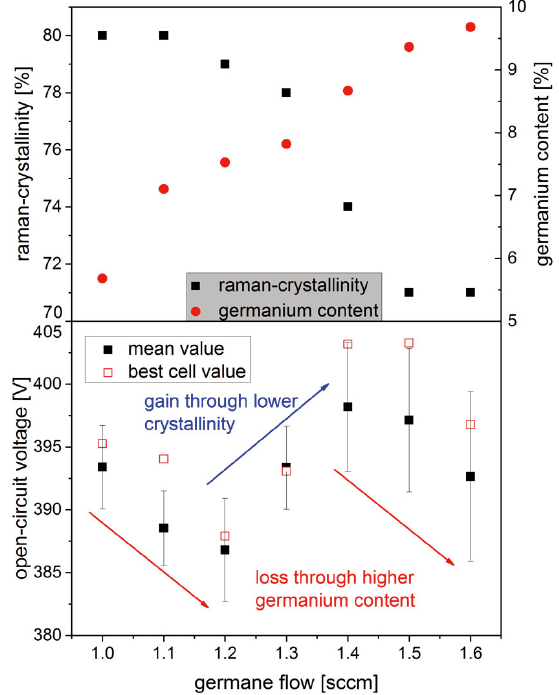
Fig. 2. Raman crystallinity, germanium content and V oc values in relation to the silane flow of single junction µ c-SiGe:H cells.